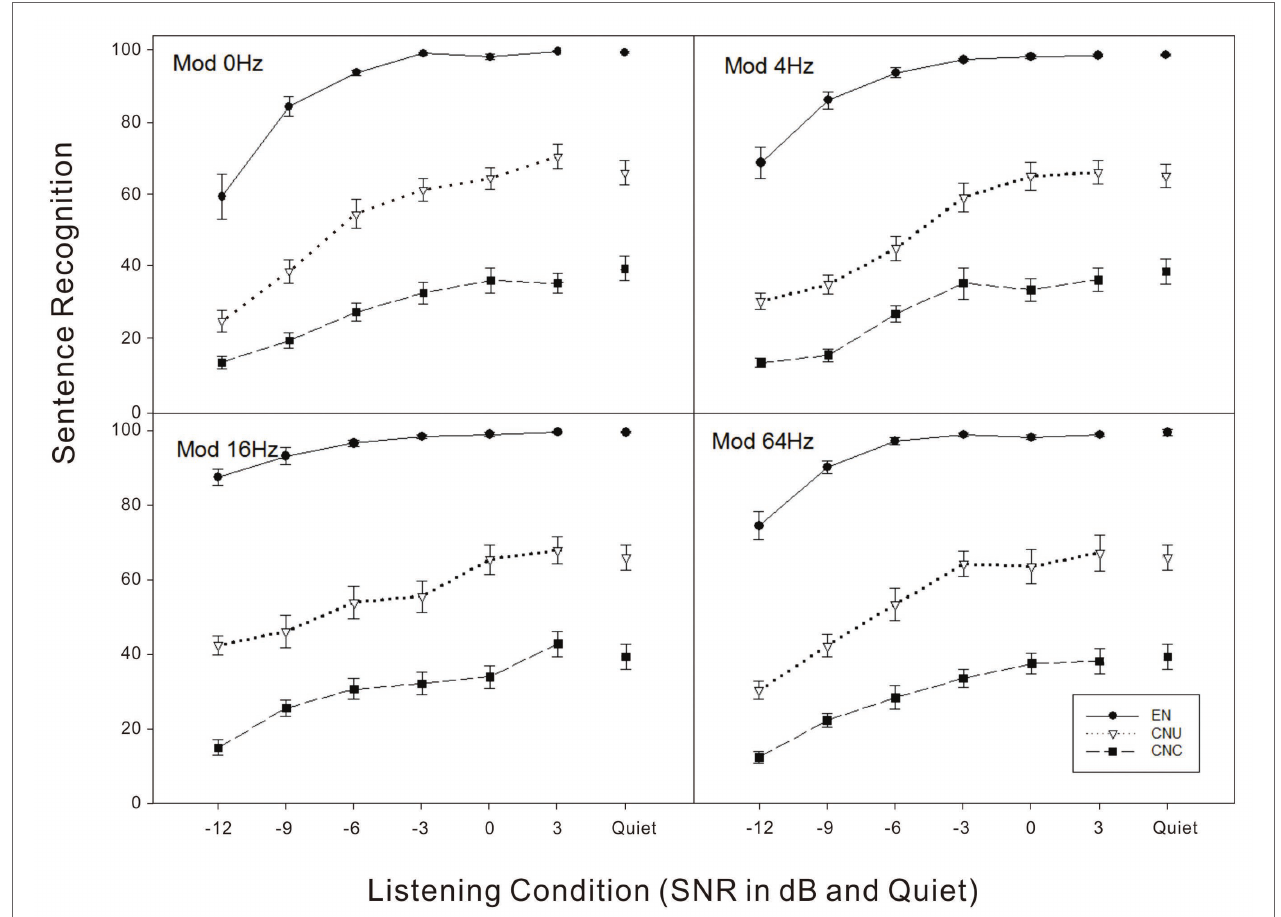
FIGURE 1 | Sentence recognition scores in percent correct as a function of listening condition (quiet and signal-to-noise ratio in dB) for four noise conditions (top left - Mod 0 Hz: stationary noise; top right - Mod 4 Hz: noise temporally modulated at 4 Hz; bottom left - Mod 16 Hz: noise temporally modulated at 16 Hz; bottom right - Mod 64 Hz: noise temporally modulated at 64 Hz) for three groups of listeners: English-native (EN) listeners, Chinese-native listeners in the United States (CNU), and Chinese-native listeners in China